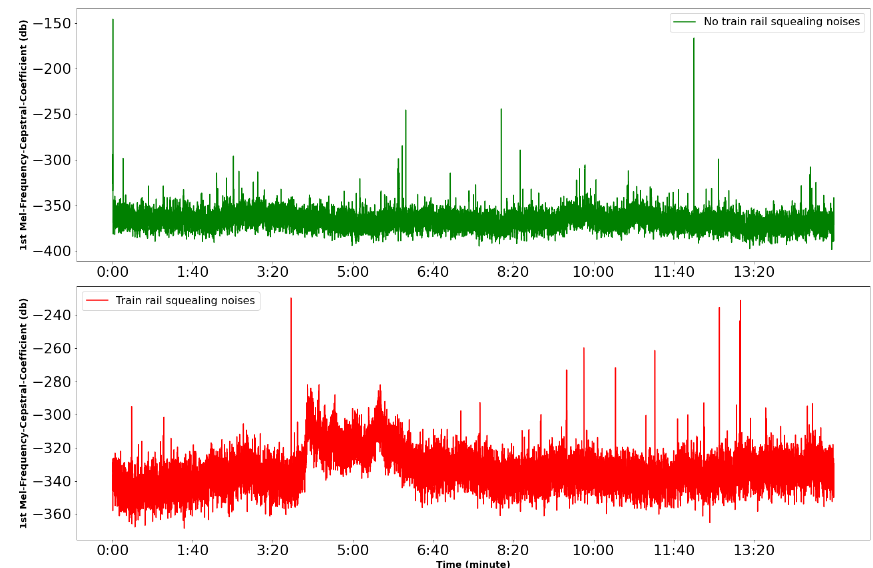
Figure 8. First mel frequency cepstral coefficient time series when there are no trains nearby ( top ) versus when the train passes by ( bottom ) within the 4:00–6:40 time range.